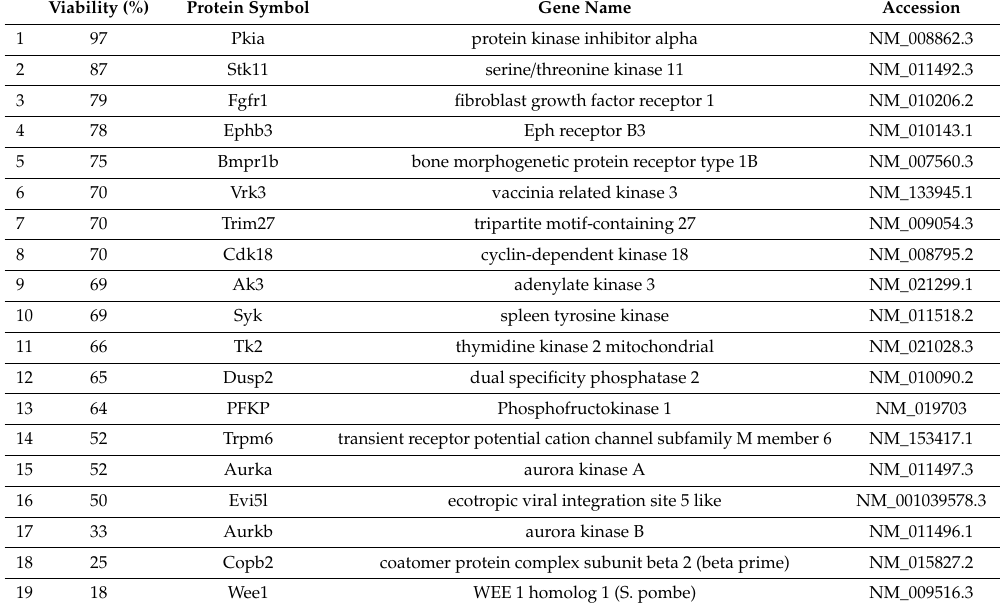
Table 1. Genes whose silencing prevents the cAMP-induced tra ffi cking of AQP2 in MCD4 cells. Hits are listed according to the e ff ects on MCD4 cell viability. Viability of non-targeting siRNA-transfected cells was considered 100%. The candidates 14–19 whose down regulation decreased MCD4 cell numbers to less than 60% were excluded from further analysis. Shown is the mean of viability from n =